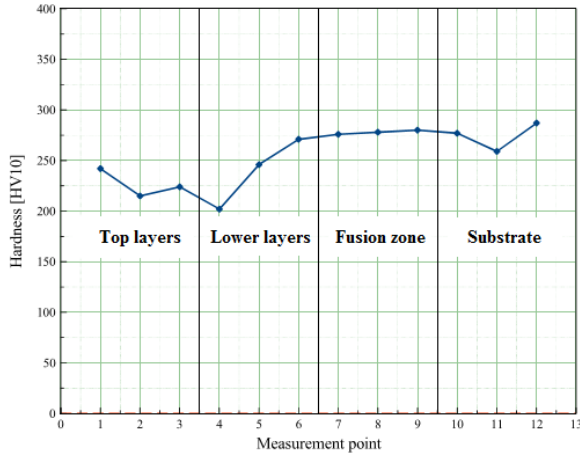
Figure 7: Hardness of deposited material test results